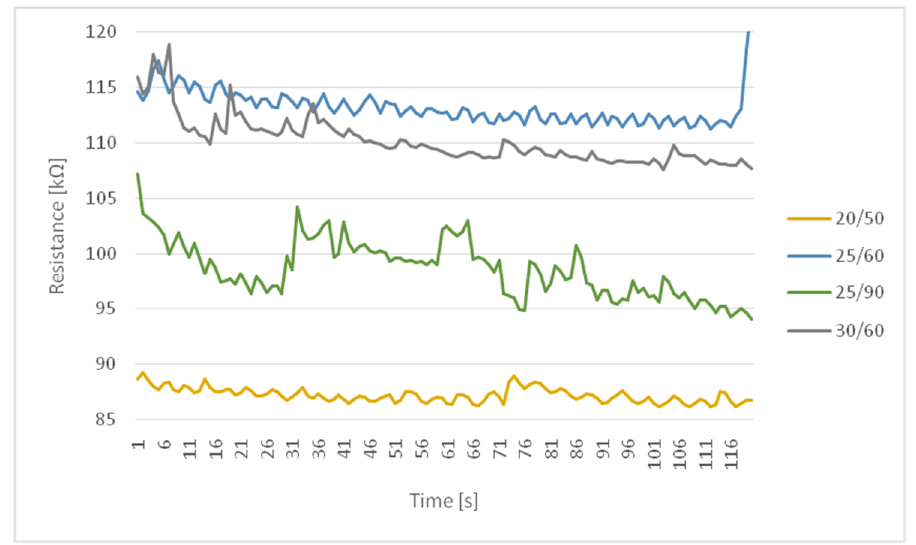
Figure 4. Summary of changes in resistance at rest. Table 2. Statistical data and variation coefficients at rest.